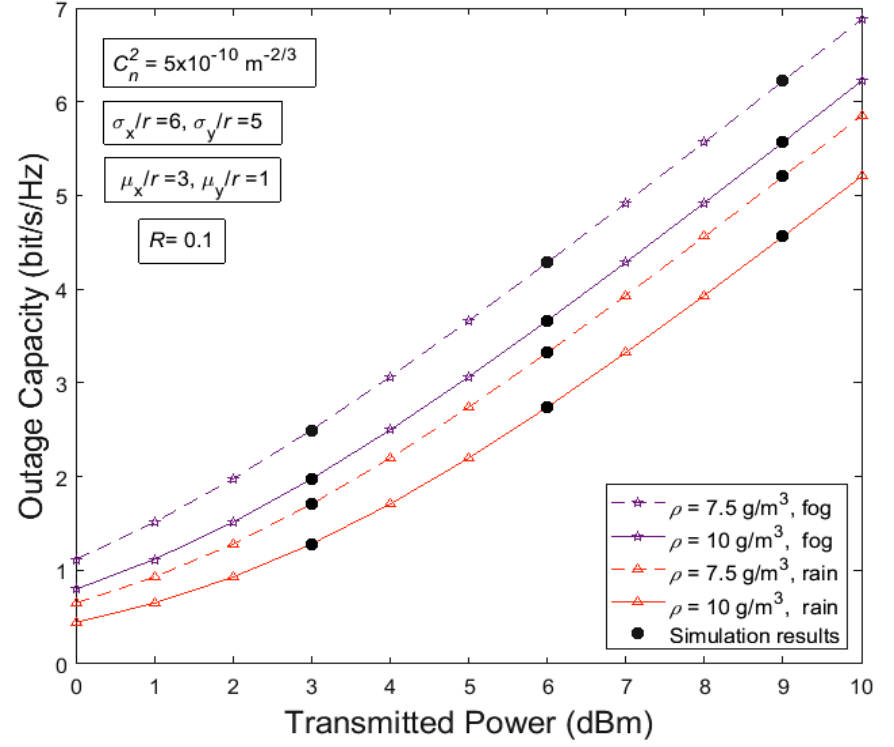
Figure 4. Outage capacity (C out /B) versus transmitted power, weak turbulence, moderate to strong water vapor concentration, weak NZB PE and R = 0.1.